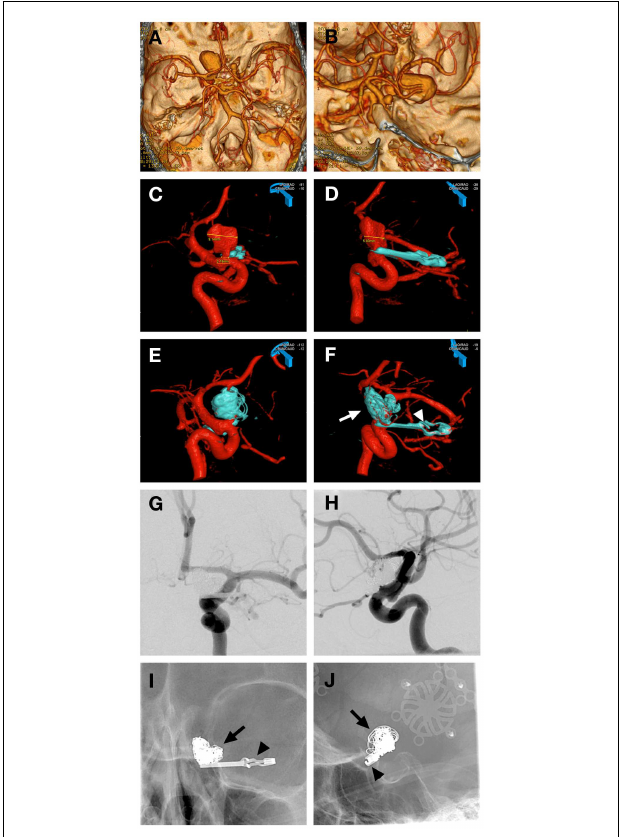
FIGURE 3 | Case 3 . (A,B) CT angiographic 3D reconstruction views showing the left giant carotid ophthalmic artery aneurysm; (C,D) 3D angiographic reconstructions from left ICA showing the left carotid ophthalmic artery aneurysm partially obliterated post clipping with a reconstructed narrow neck by the microsurgical clip (blue); (E,F) 3D angiographic reconstructions from left ICA post clipping and coiling with the giant aneurysm completely obliterated by the microsurgical clip (arrowhead) and the coil mass (arrow); (G,H) AP and lateral magnified subtracted left ICA angiographic views showing complete obliteration of aneurysm with clip and coils, ophthalmic artery is patent and well visualized (H) ; (I,J) AP and lateral magnified skull x-rays showing the microsurgical clip (arrowhead) and coil mass (arrow).